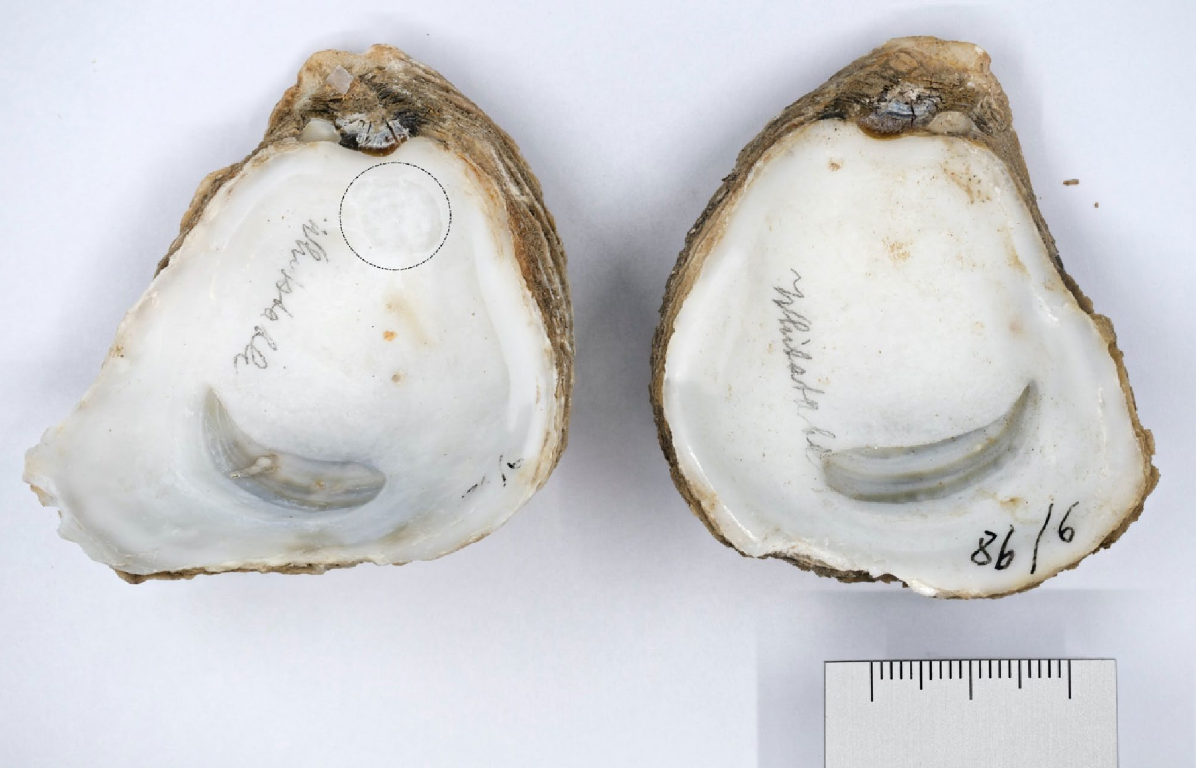
Figure 1. Macroscopic photography of both shells of one individual of Ostrea edulis, belonging to the collection of the Zoological museum Kiel. The left shell has a drill hole of approximately 8 mm in diameter underneath the ligament (circled). The right shell is